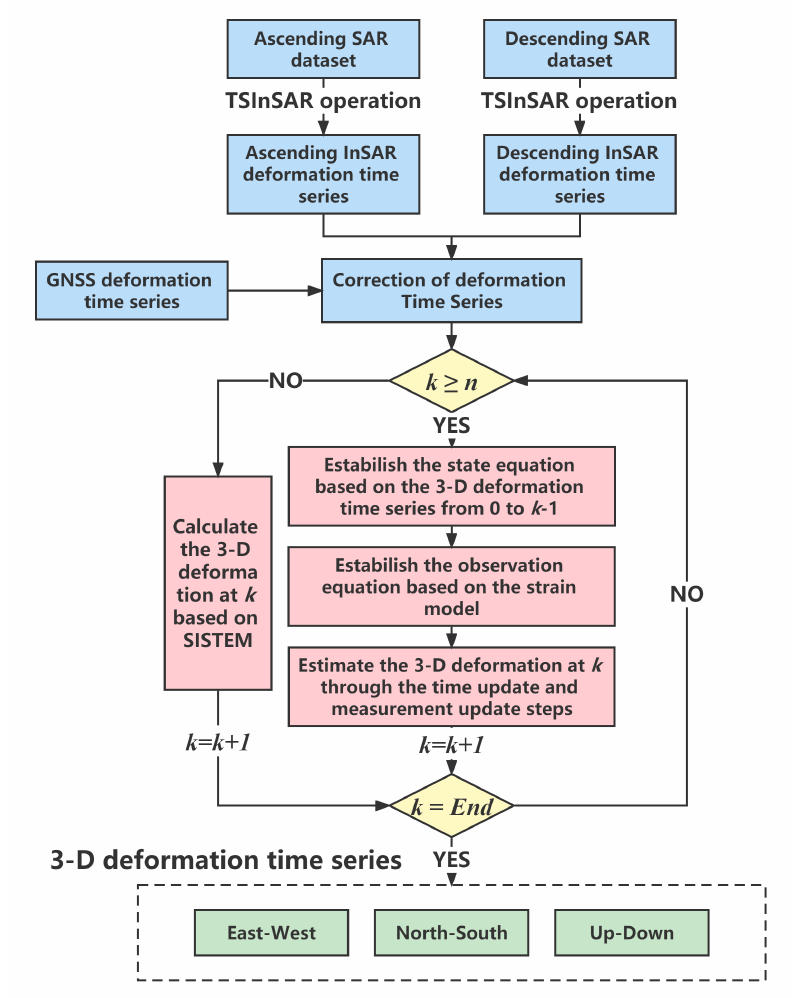
Figure 2. Flow of operating the SM-Kalman